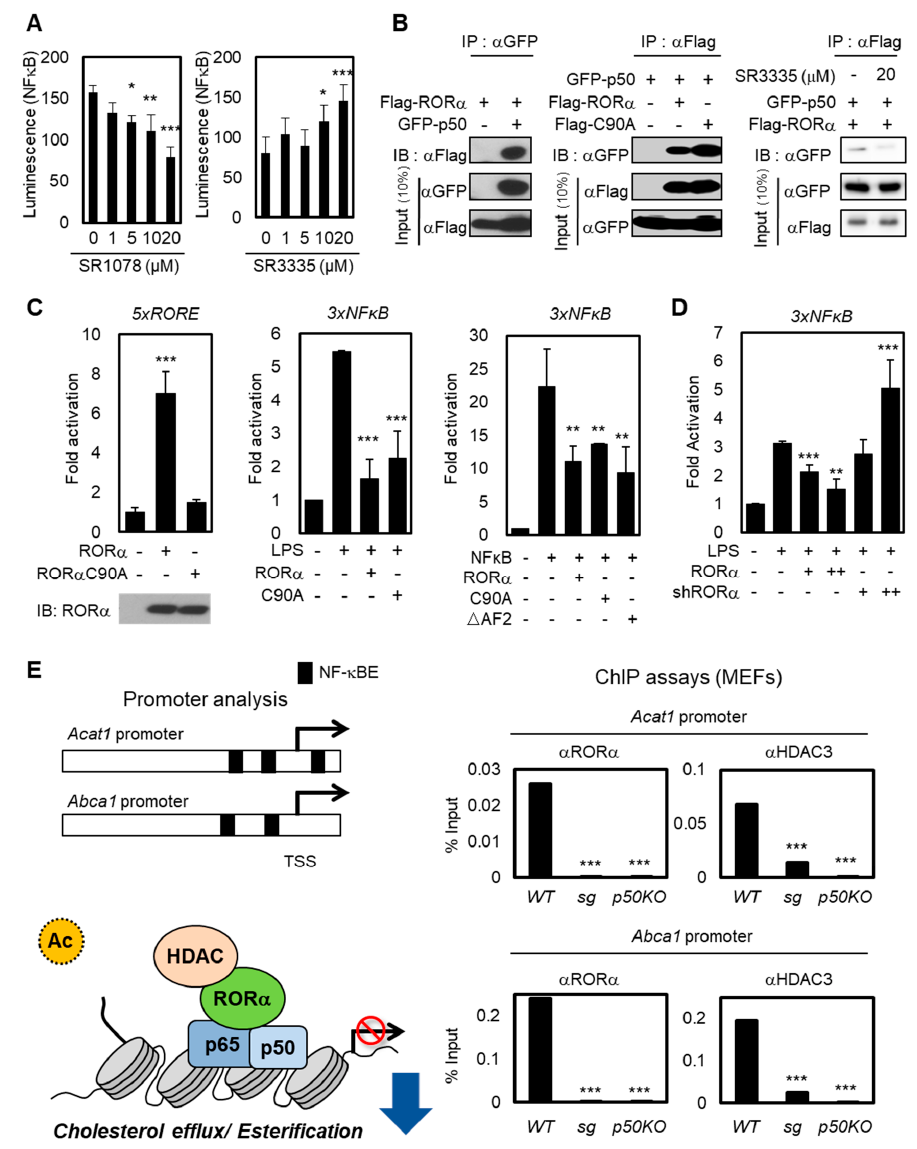
Figure 2. ROR α potentiates T cell cholesterol synthesis via NF- κ B inhibition. ( A ) NF- κ B-luciferase reporter-expressed Jurkat cells were treated with SR1078 or SR3335 at doses of 1, 5, 10, and 20 µ M for 1 day. Luciferase was reacted by the Luciferase Assay System and measured using a microplate reader. The p -value was calculated by a t -test (* p < 0.05, ** p < 0.01, *** p < 0.001). ( B ) Co-immunoprecipitation assays between ROR α and p50, NF- κ B component (left). The binding affinity of ROR α WT or C90A with p50 was assessed in 293T cells (middle). The binding between ROR α and p50 was assessed with SR3335 treatment in 293T cells (right) ( C ) The introduction of ROR α C90A decreased the transcriptional activation of the 5XRORE luciferase reporter (left). Compared to RORE, the introduction of ROR α WT, C90A, and Δ AF2 mutants had the same effect of transrepression on the 3XNF κ B luciferase reporter (middle and right). The p -value was calculated by a t -test (** p < 0.01, *** p < 0.001). ( D ) Effects of ROR α knockdown on 3XNF κ B luciferase reporter in 293T cells treated with LPS (shROR α , + : 0.5 µ g / µ L, ++ : 2 µ g / µ L). ( E ) The illustration represents the location of NF- κ B elements on Acat1 and Abca1 promoter. Proposed model of ROR α recruitment with HDAC3 and binding on the NF- κ B target promoters (left). ChIP assays on Acat1 or Abca1 promoters in WT, ROR KO ( sg ), or p50 KO MEFs (right). The p -value was calculated by a t -test (*** p <